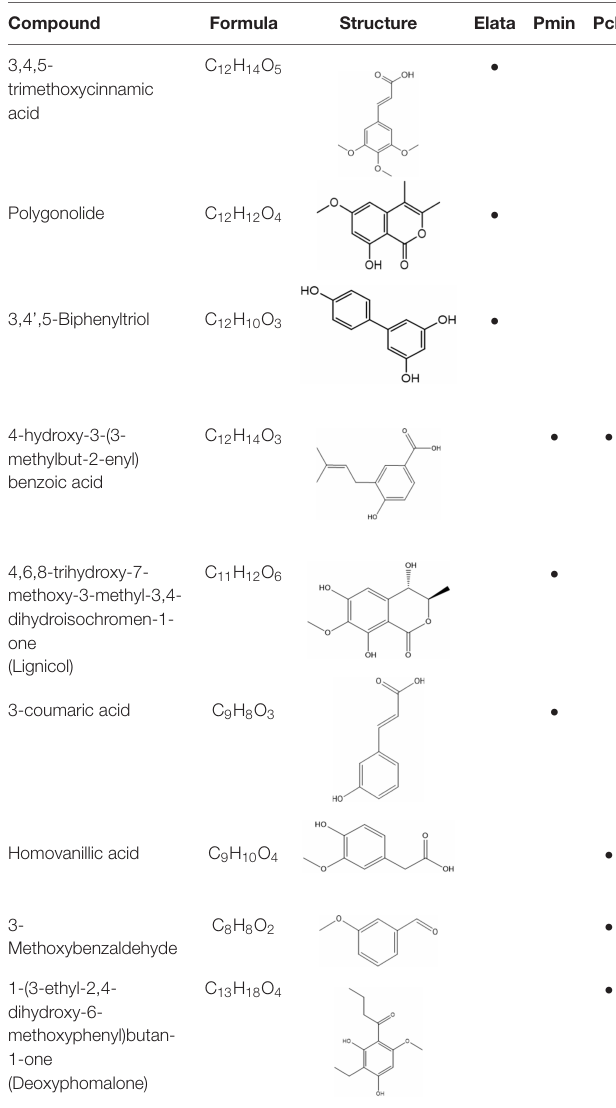
TABLE 3 | Mass spectral analysis of phenolic, aldehydes, and carboxylic acid metabolites produced by E. lata , P. minimum , and P. chlamydospora without reported iron reduction